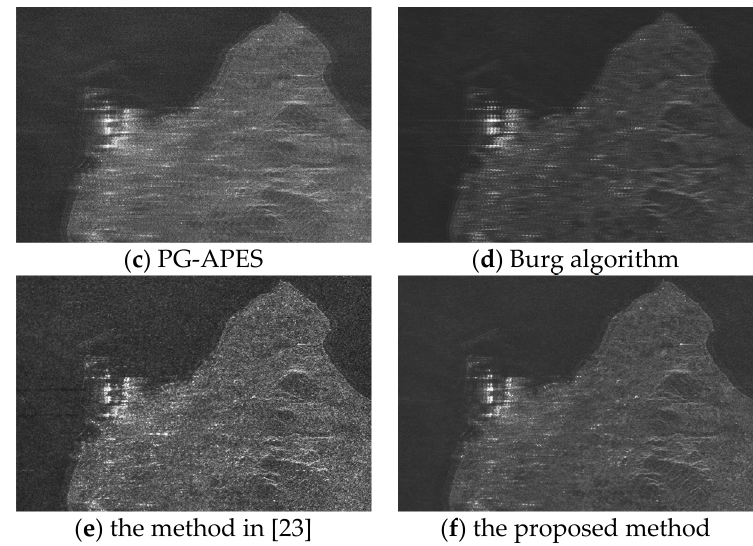
Figure 23. Results of Region 1: ( a ) complete data; ( b ) adding zeros operation; ( c ) PG-APES; ( d ) Burg algorithm; ( e ) the method in [23]; and ( f ) the proposed method.